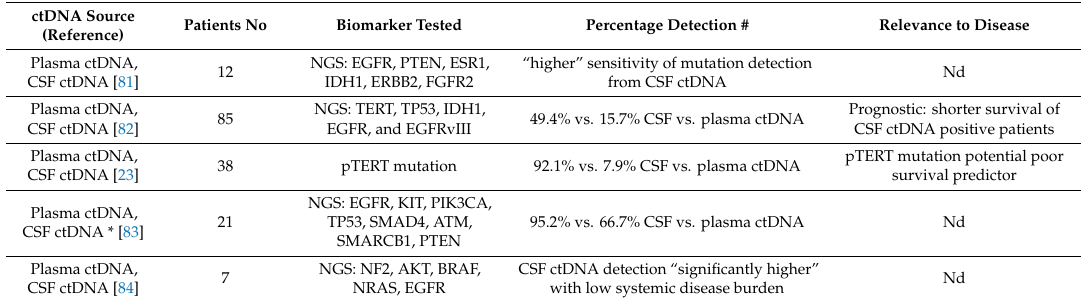
Table 3. Comparison of CSF and blood derived